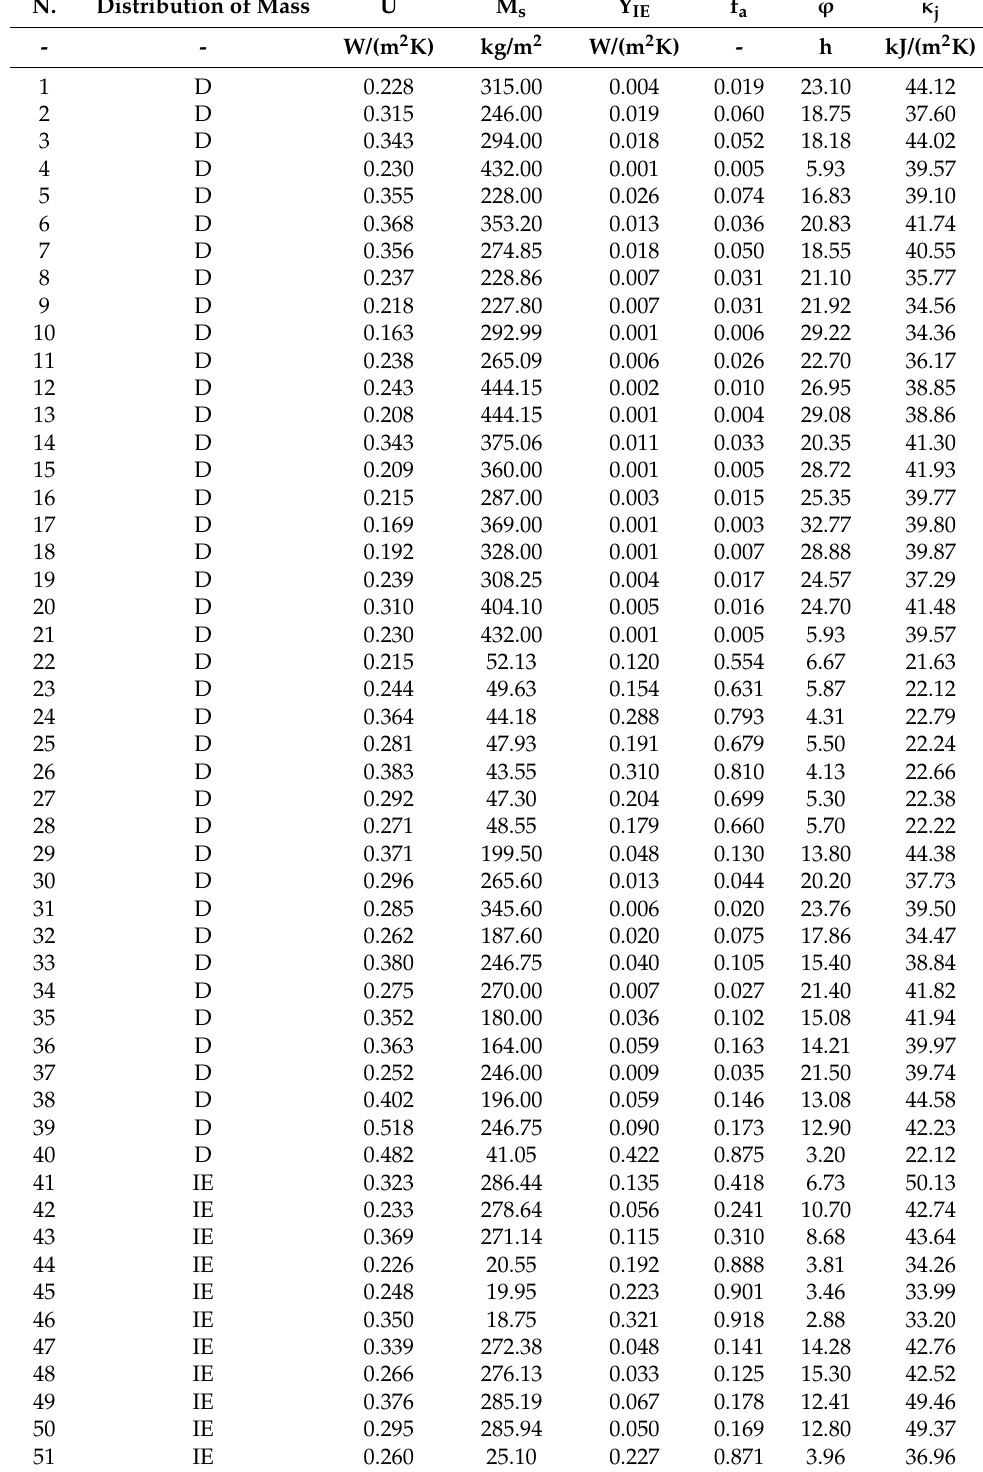
Table A1. Thermo-physical properties of all stratigraphies used for case study